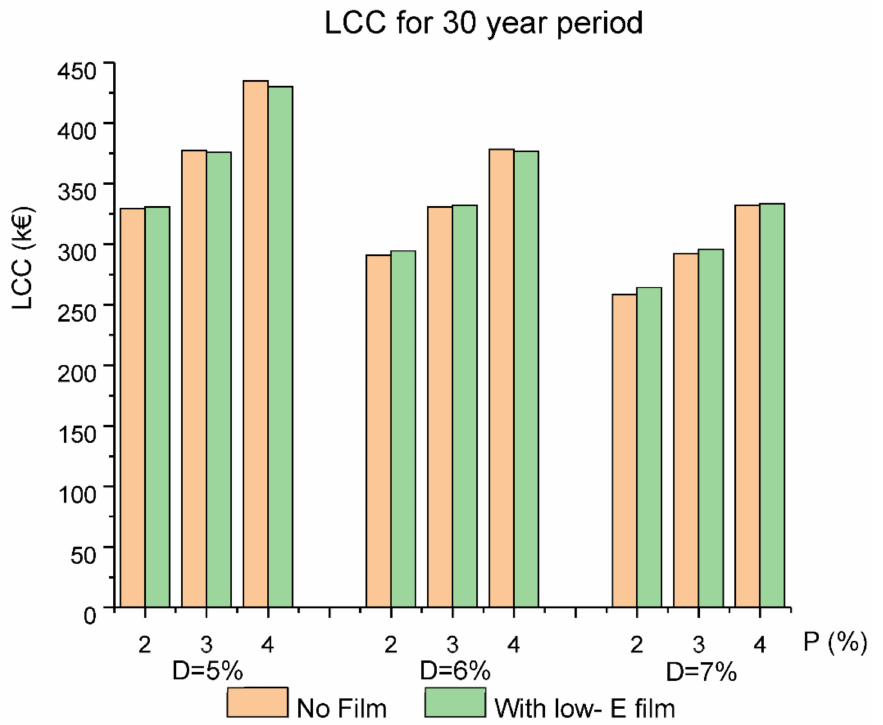
Figure 27. Life cycle cost for a calculation period of 30 years. Nominal discount rate (D) and price escalation (P) with inflation rate of